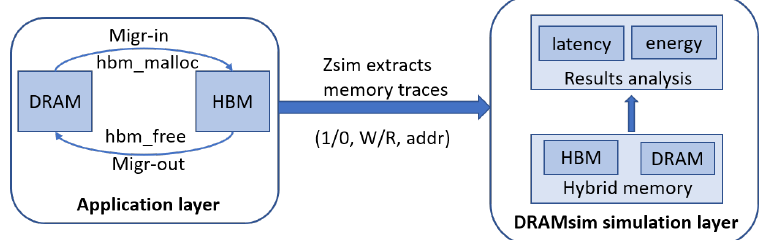
Figure 5. The modeling architecture and process of our